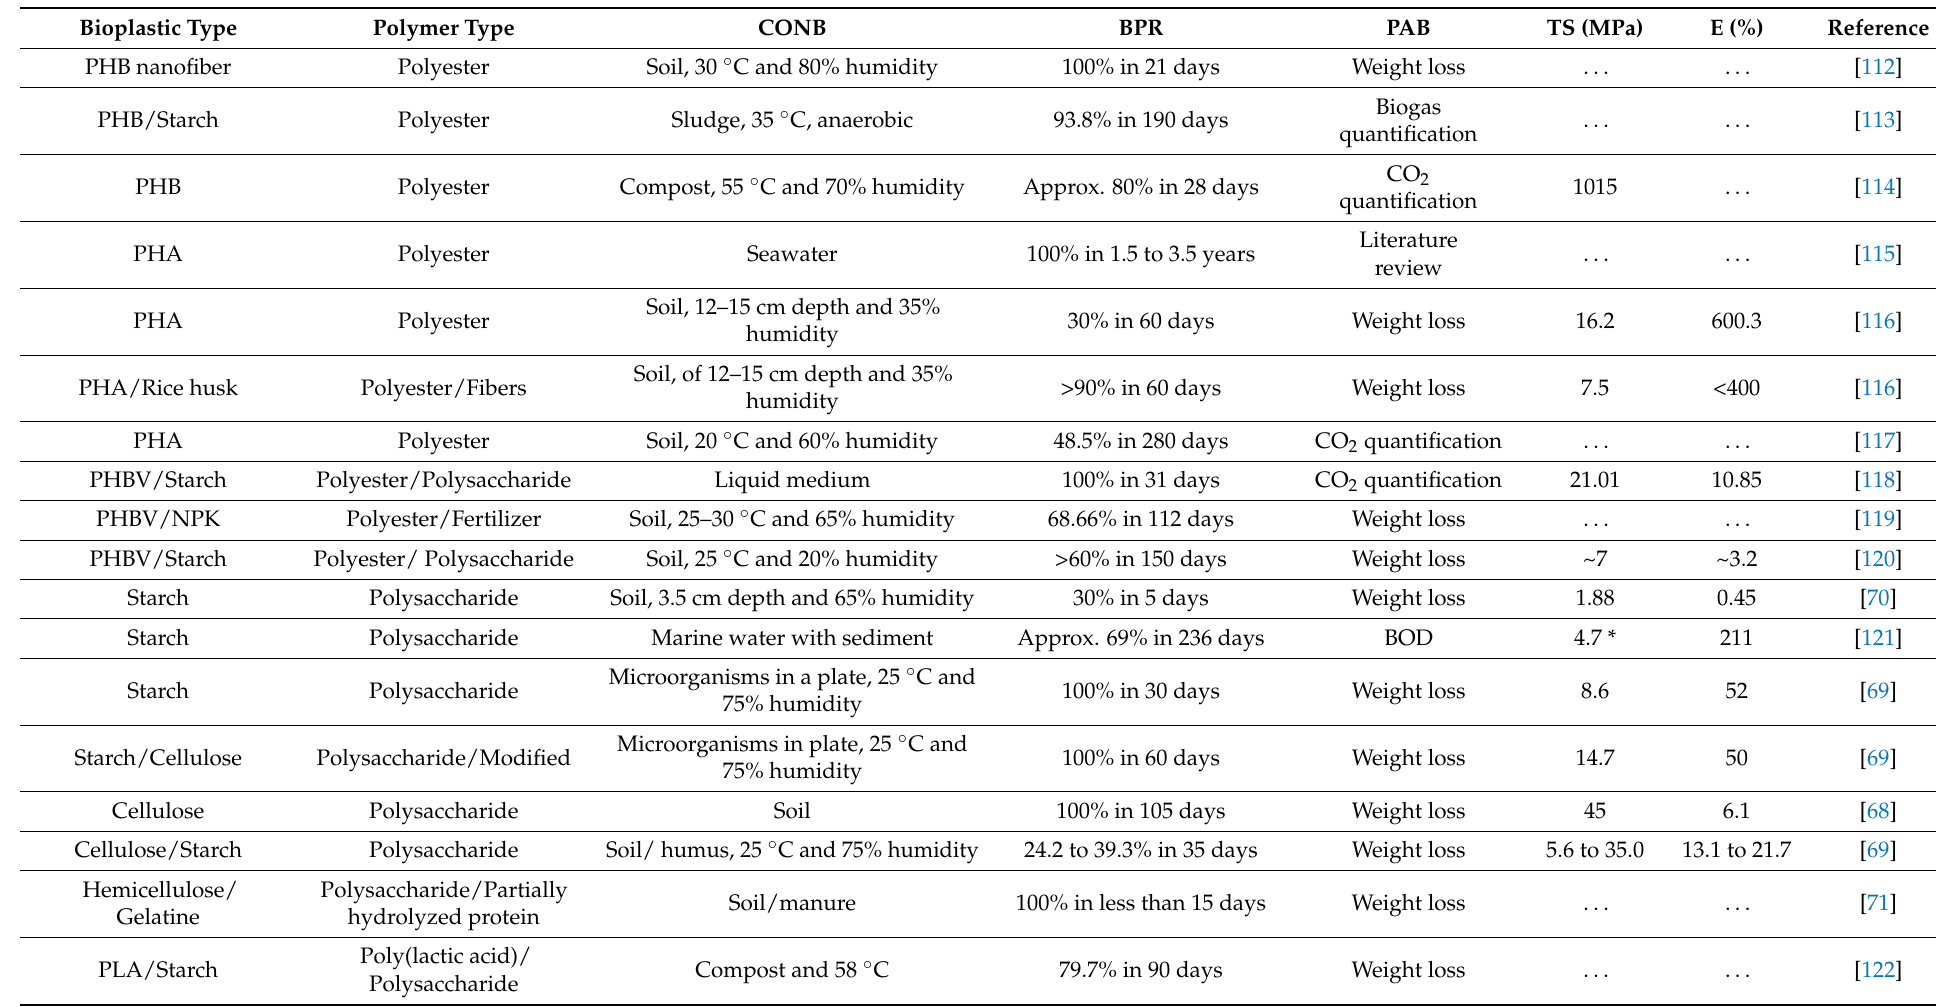
Table 1. Properties and biodegradation time of different biodegradable bioplastics produced from biopolymers. Bioplastic